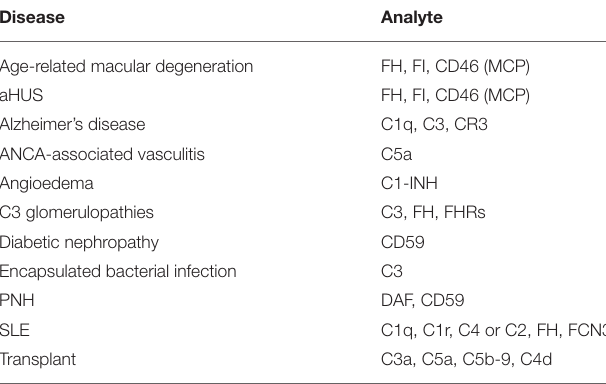
TABLE 1 | Complement-related diseases and disease processes. Disease